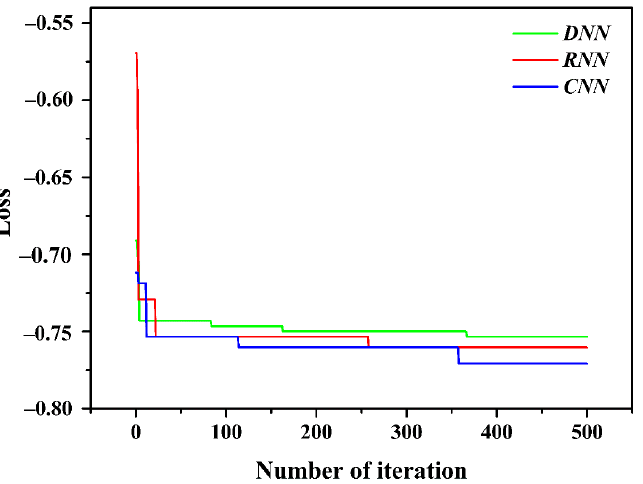
Figure 10. The TPE optimization loss in the iterative process of three typical neural network models.